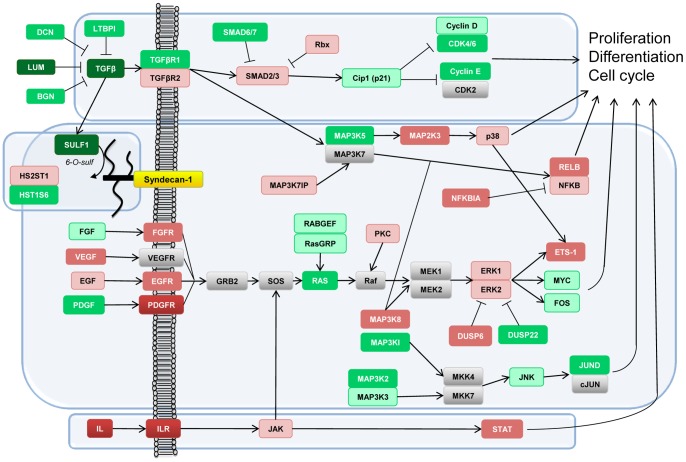
Schematic representation of genes and signaling pathways affected by syndecan-1 overexpression based on KEGG pathways.The figure summarizes the most important findings related to syndecan-1 overexpression. Green, red and gray boxes respectively show downregulated, upregulated and unaffected genes by syndecan-1 overexpression. Color intensity is proportional with fold change (FC): dark red and dark green correspond to a FC≥9, red and green correspond to a FC<9 and FC≥2, light red and green correspond to a FC<2 and FC≥1.5. Syndecan-1 acts on several growth-factor related pathways at multiple levels as illustrated by the TGF-beta pathway. The elements of JAK-STAT pathway are enhanced. The expression of growth factor receptors is mainly overexpressed. The MAPK cascade is perturbed at different points, receiving both direct and indirect signals, collectively leading to alterations of various transcription factors and cellular responses such as proliferation and cell-cycle regulation.